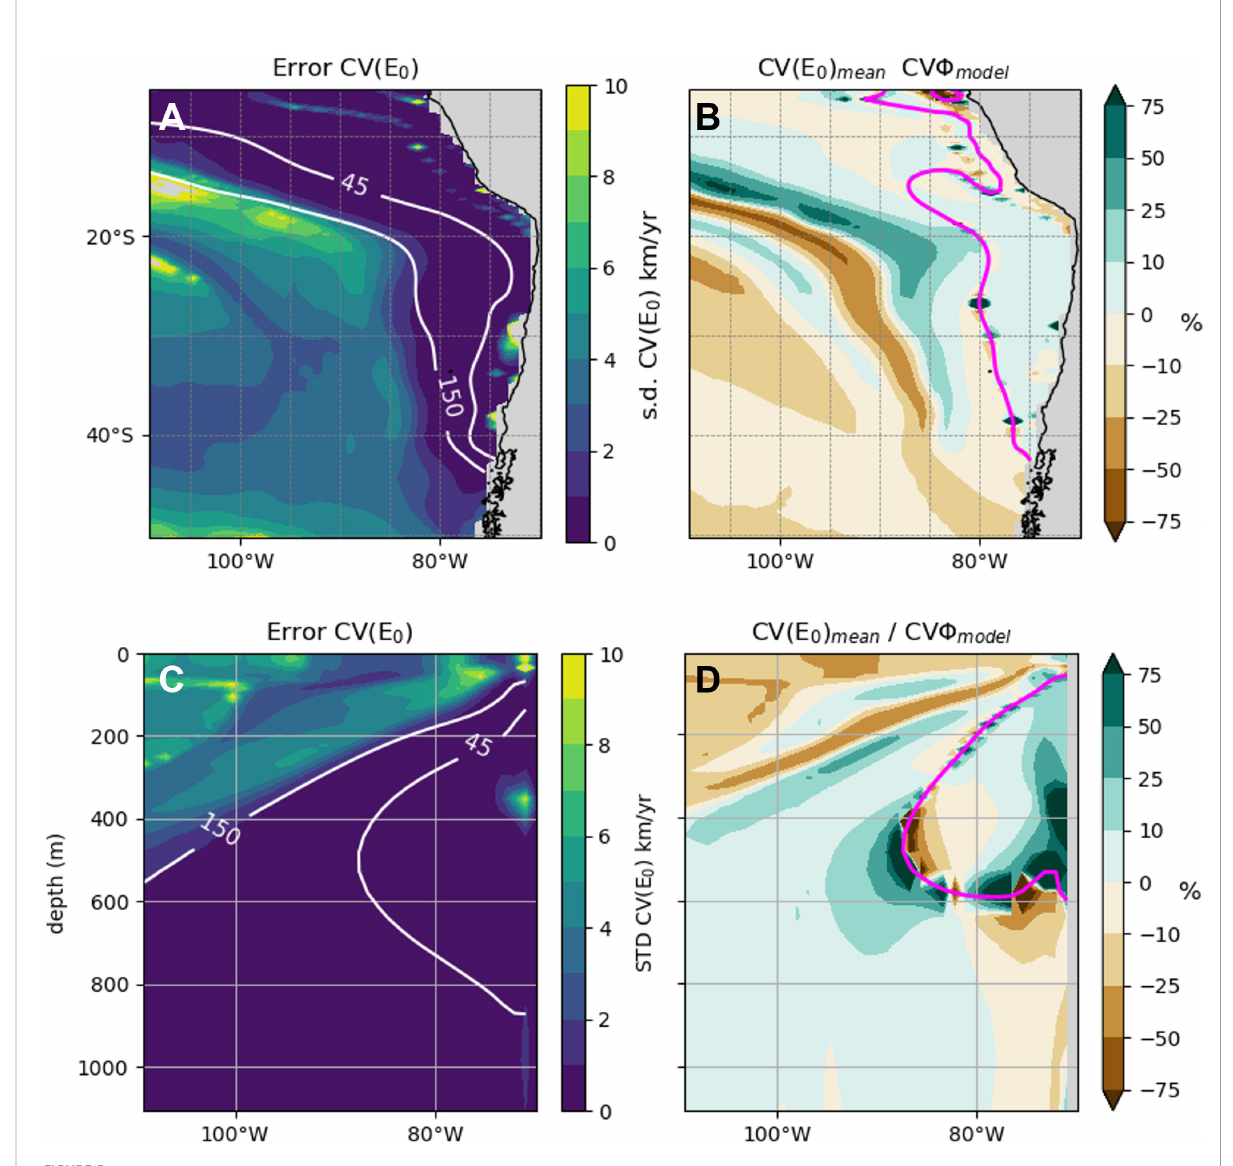
FIGURE 5 Sensitivity of CV F to the physiological trait E 0 . At 200m (top) and 26°S (bottom). (A, C) provide the absolute uncertainty and (B, D) the relative uncertainty (see method section 2.4.1). The range of E 0 used is provided in Figure S4. (B, D) represent the relative difference between CV(E 0 ) mean and CV F ,model in %. The white contours indicate the 45 and 150 oxygen isocontours (mmol.m -3 ). The magenta lines indicate where CV Ф ,model = 0 km.yr -1 (i.e. the transition